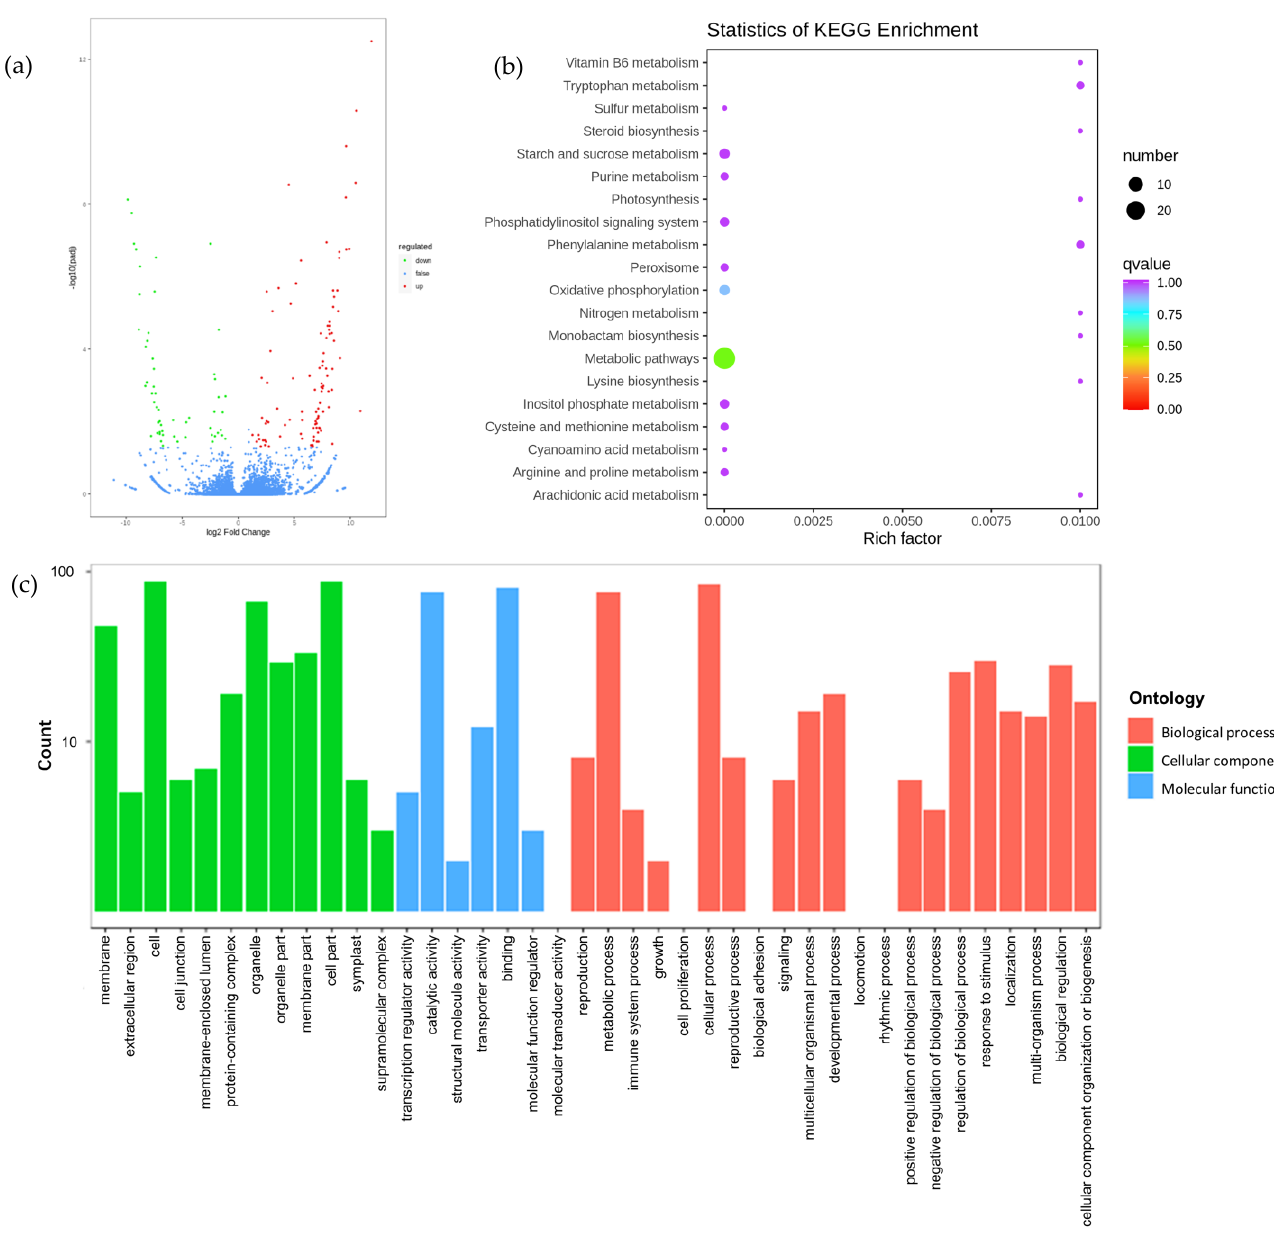
Figure 4. Volcano diagram, KEGG, and GO enrichment analysis diagram of differentially expressed genes in ‘Feizixiao’ litchi pulp obtained by comparing the treated and control groups at 69 DAA in 2020: ( a ) Volcano diagram; ( b , c ) KEGG and GO enrichment analysis diagram.